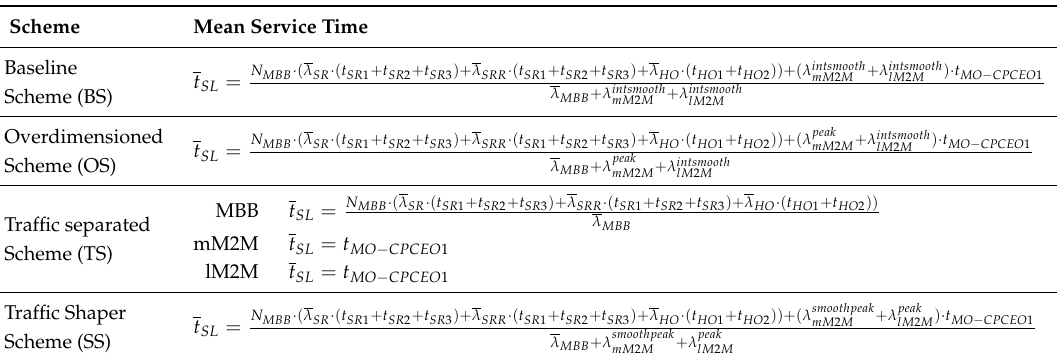
Table 3. SL’s mean service